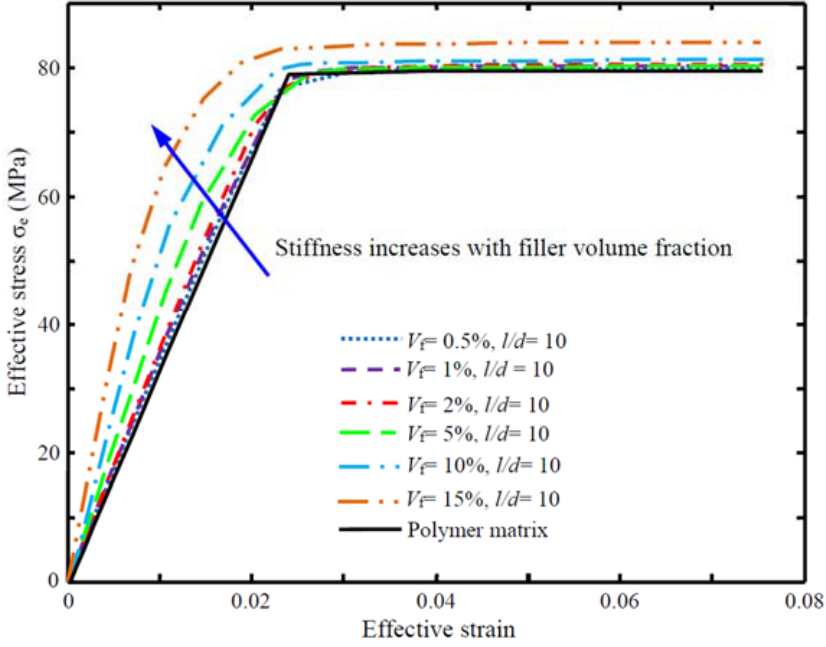
Figure 12. Effective stress-strain diagram σ e - ε e of the PNCs with the clay-particle aspect ratio ρ = 10 (plane-stain, case II).